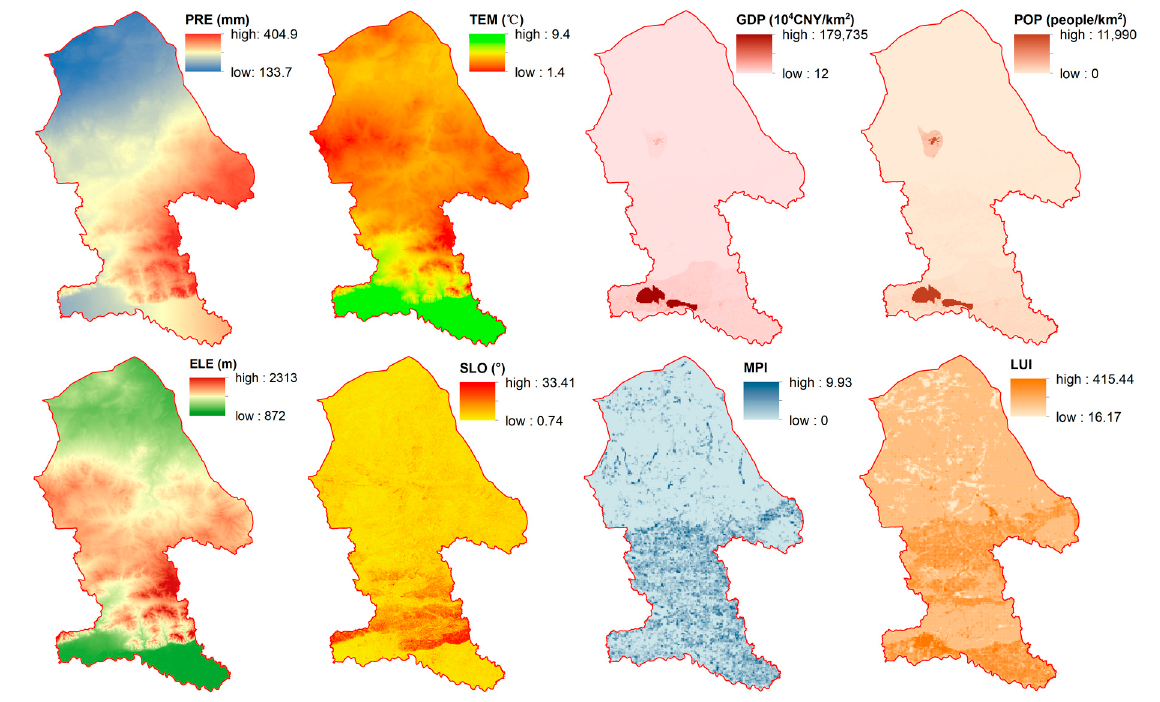
Figure 2. Spatial distribution of variable data in 2015.